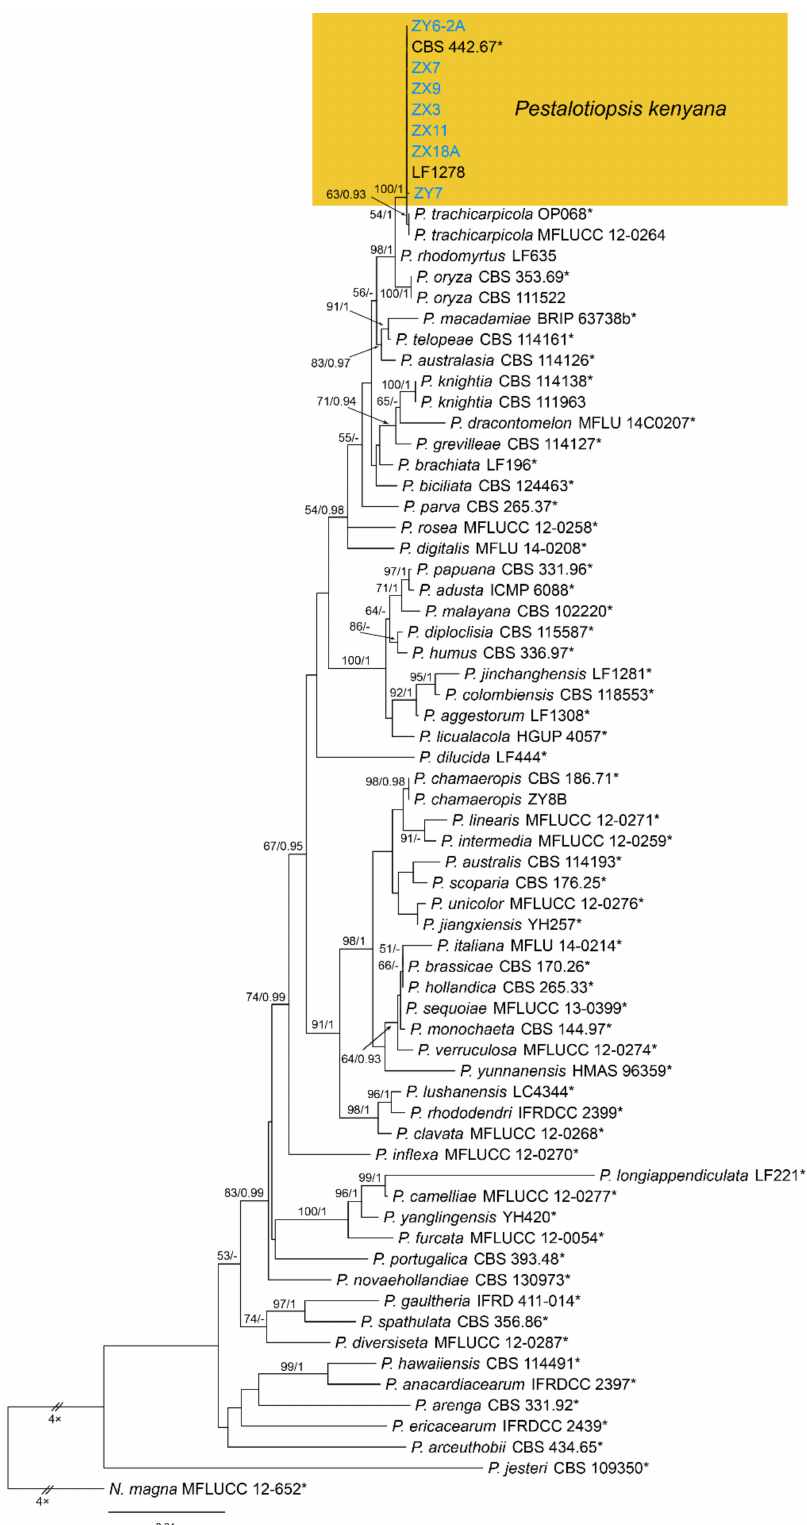
Figure A7. Phylogram generated from RAxML analysis based on combined ITS, tef1 and tub2 sequence data of Pestalotiopsis isolates. The tree was rooted to Neopestalotiopsis magna (MFLUCC 12-652). The scale bar indicates 0.04 nucleotide changes per site. Isolates from this study are marked in blue, ex-type strains are marked with *, and the identified species is marked in